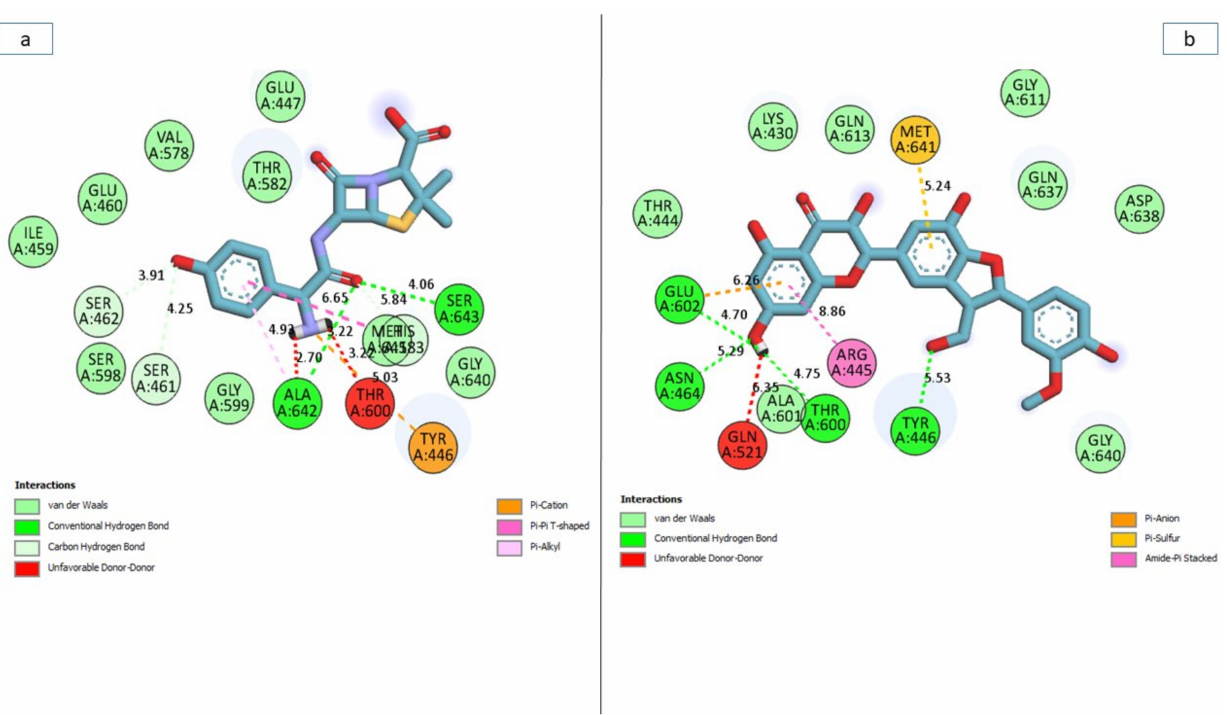
Figure 12. Plot of interactions of amoxicillin ( a ) and silicristin ( b ) against the active site of PBP2a of S. aureus